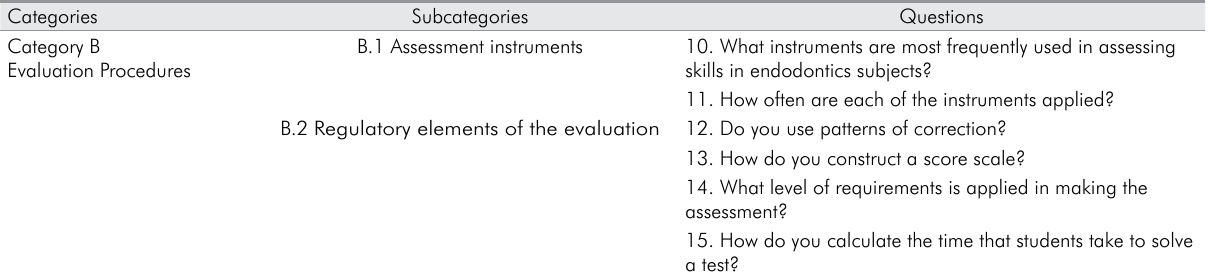
Table 2. Example of Instrument: Questions made by the interviewer to teachers in Category B.